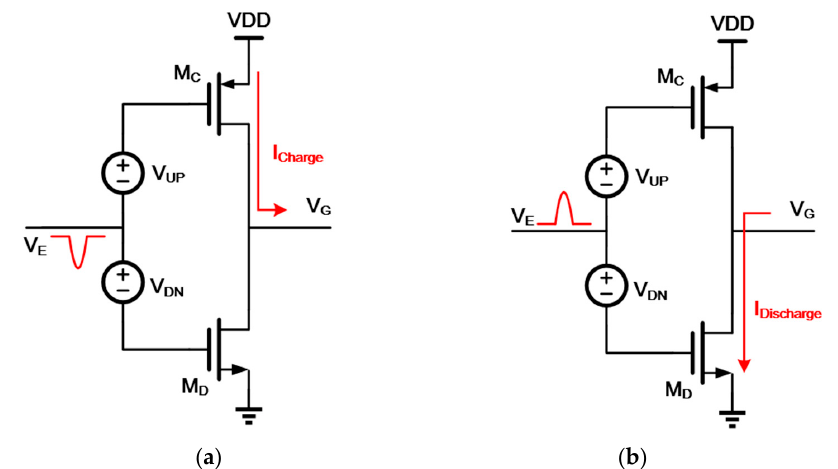
Figure 3. Large-signal response of the push–pull buffer ( a ) charge ( b ) discharge.